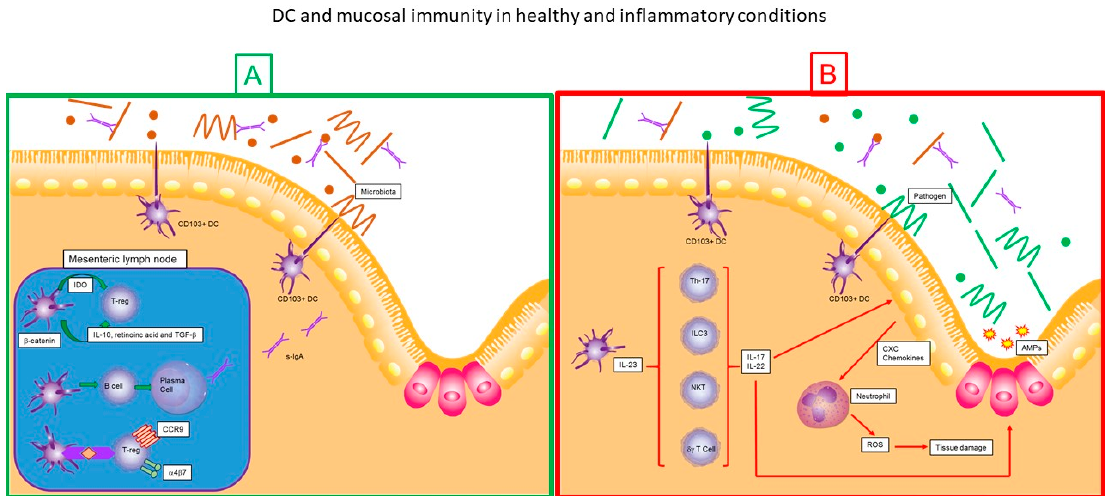
Figure 3. Dendritic cells and mucosal immunity in healthy and inflammatory conditions. Schematic representation of the interaction between gut microbiota, dendritic cells and inflammatory response in gut mucosa in a healthy state ( A ), and gut mucosa in dysbiotic–inflammatory state ( B ). α 4 β 7: α 4 β 7 Integrin, AMPs: antimicrobial peptides, CCR9: C-C chemokine receptor type 9, CXC: CXC Chemokines family, DC: Dendritic Cell, IDO: Indoleamine-pyrrole 2,3-dioxygenase, IL-10: Interleukin 10, IL-17: Interleukin 17, IL-22: Interleukin 22, IL-23: Interleukin 23, ROS: Reactive oxygen species, s-IgA: Secretory Immunoglobulin A, TGF- β : Transforming growth factor beta, T-reg: Regulatory T cells.